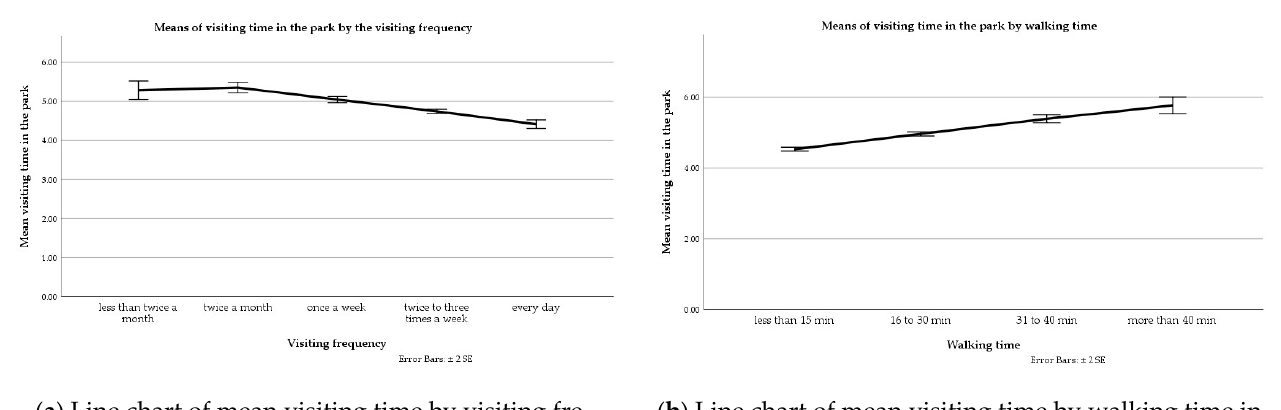
Figure 5. Variations in mean visit duration in the individual’s most frequently visited park on foot by ( a ) visiting frequency and ( b ) walking time.